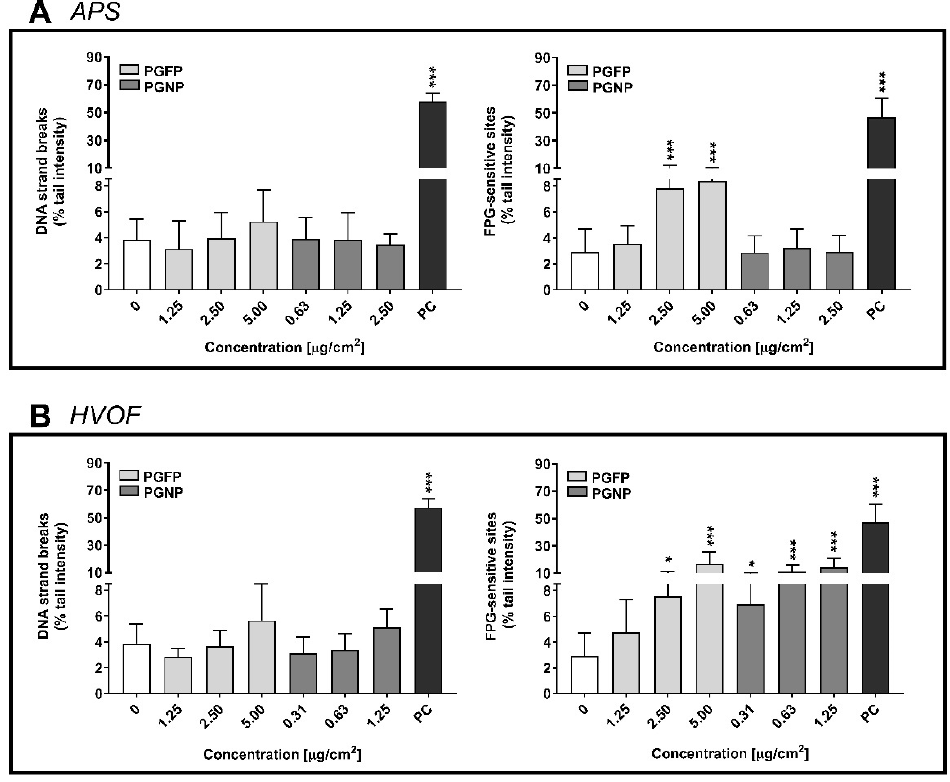
Figure 6. Primary (DNA strand breaks) and oxidative (FPG-sensitive) DNA damage in human alveolar epithelial cells after 24 h of exposure to PGFP and PGNP particles released during APS ( A ) and HVOF ( B ). Data are expressed as means ± standard deviations (n = 3–4). Data were analysed by one-way ANOVA followed by Dunnett’s post-hoc test. * p ≤ 0.05and *** p ≤ 0.001 vs. NC. PC: 500 µM MMS and 2.5 mM KBrO 3 for primary and oxidative DNA damage, respectively.